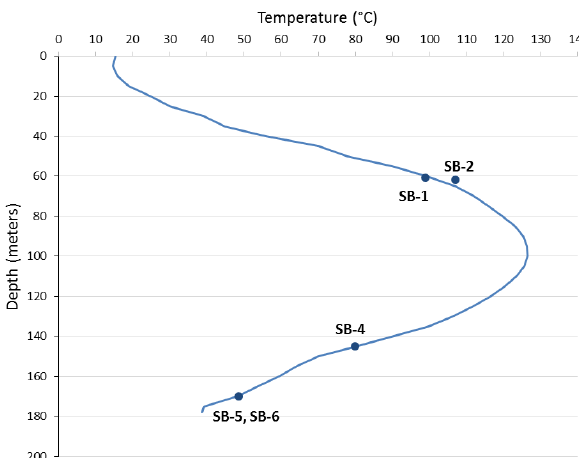
Figure 5. Temperatures at 5m intervals along the drill hole, from the surface down to the bottom at 178m. The circles show the depth and temperature of the SB